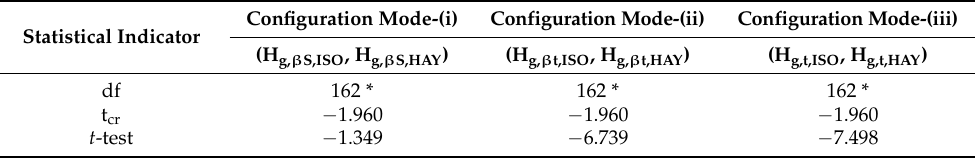
Table 2. T -test per pair of the ISO- and the HAY-derived solar radiation values for Saudi Arabia in the period 2005–2016 for the 3 solar system configuration modes under all-sky conditions. df = degrees of freedom, t cr = critical value for the t -test. The confidence interval is 95% ( α = 0.05). Statistical